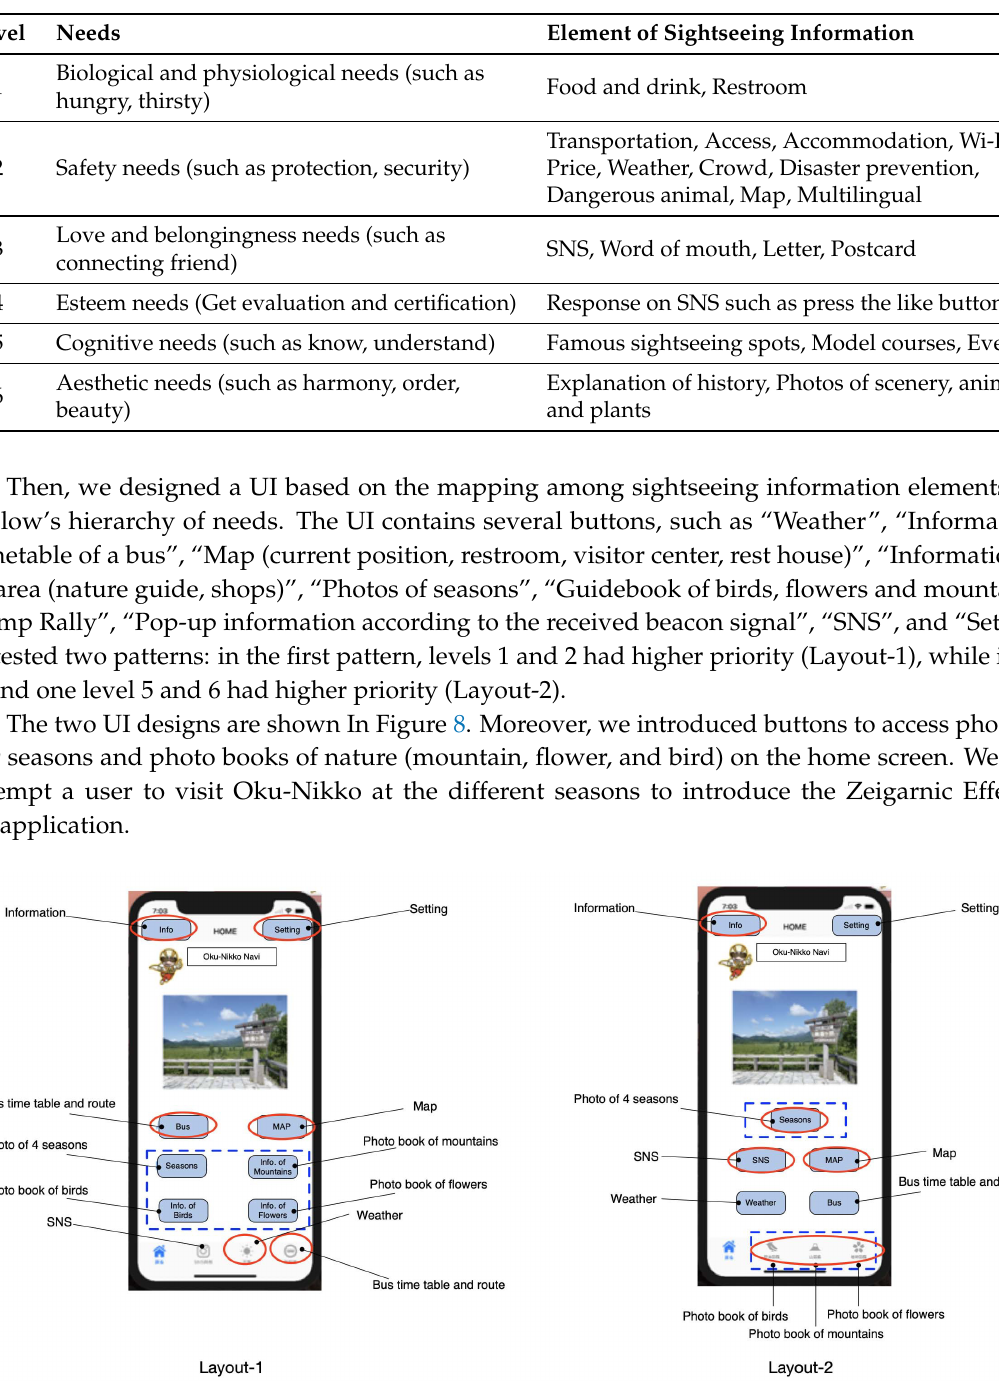
Table 2. Mapping among elements of sightseeing information and Maslow’s hierarchy of needs.